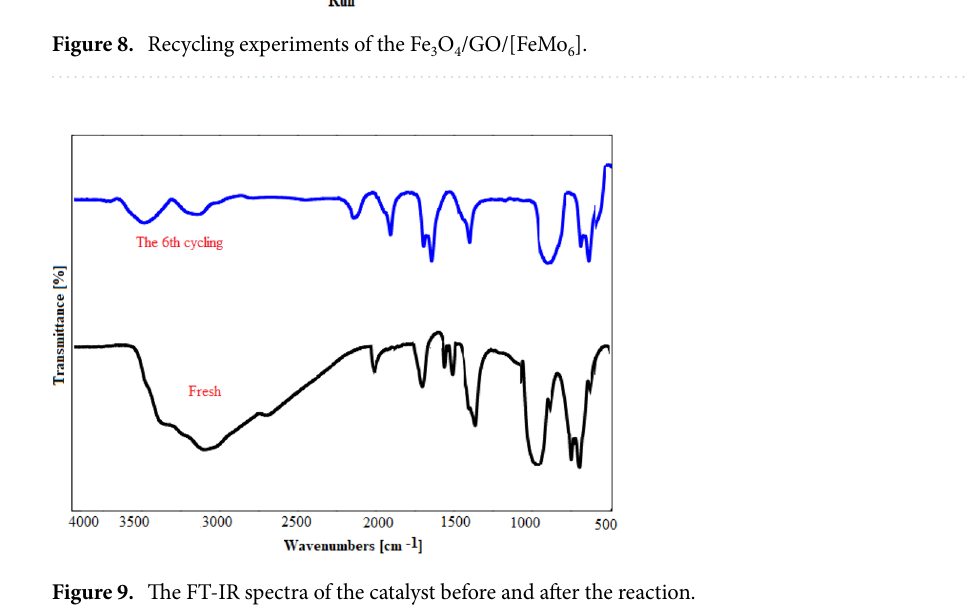
Figure 9. The FT-IR spectra of the catalyst before and after the reaction.